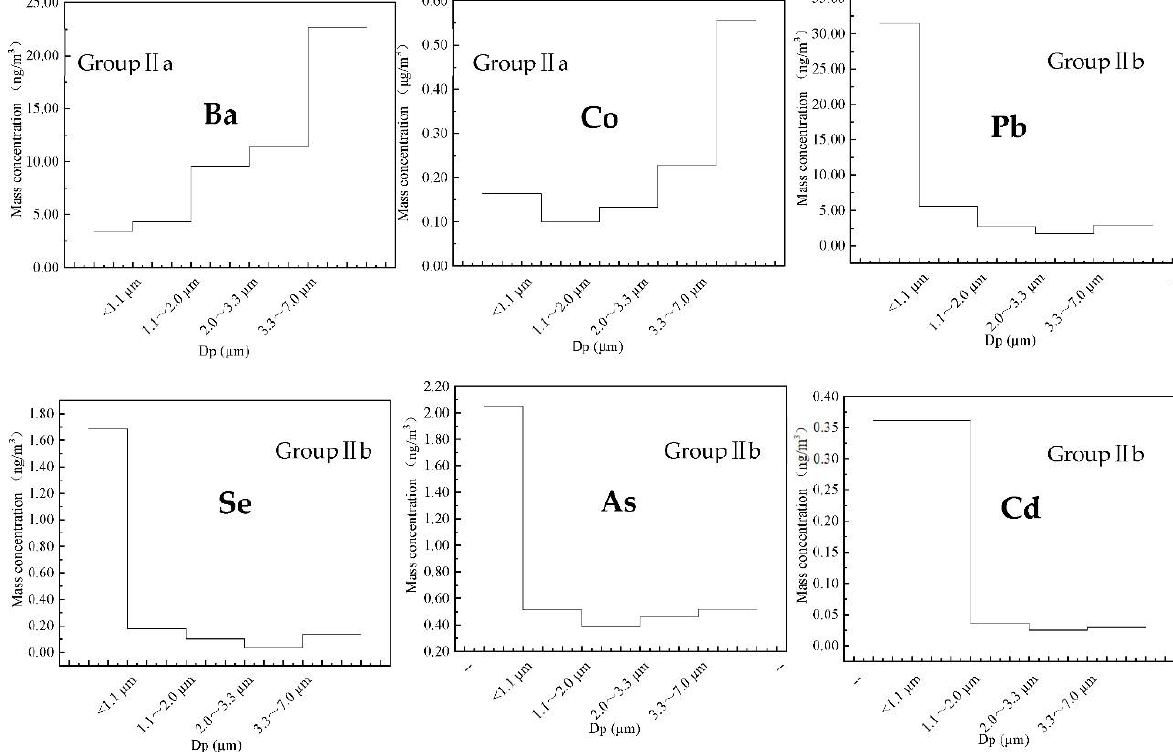
Figure 6. Potentially toxic metals with particle size - unimodal distribution. Group II a is the mass concentration mainly concentrated in PM >7 . 0 ; Group II b is the mass concentration mainly concentrated in PM 1 . 1 .